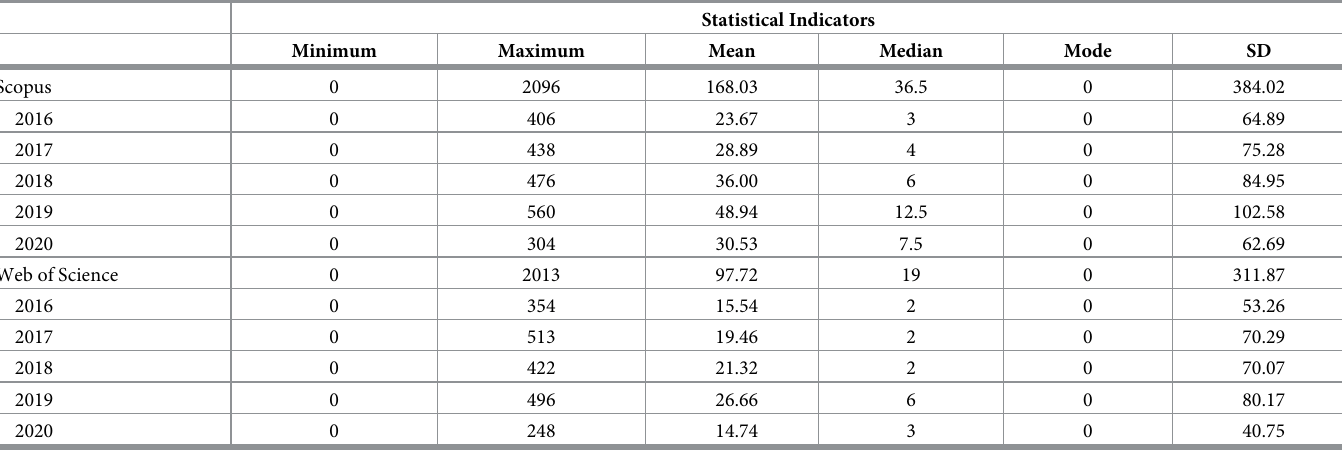
Table 3. Scientific production of Peruvian universities and licensed graduate schools.